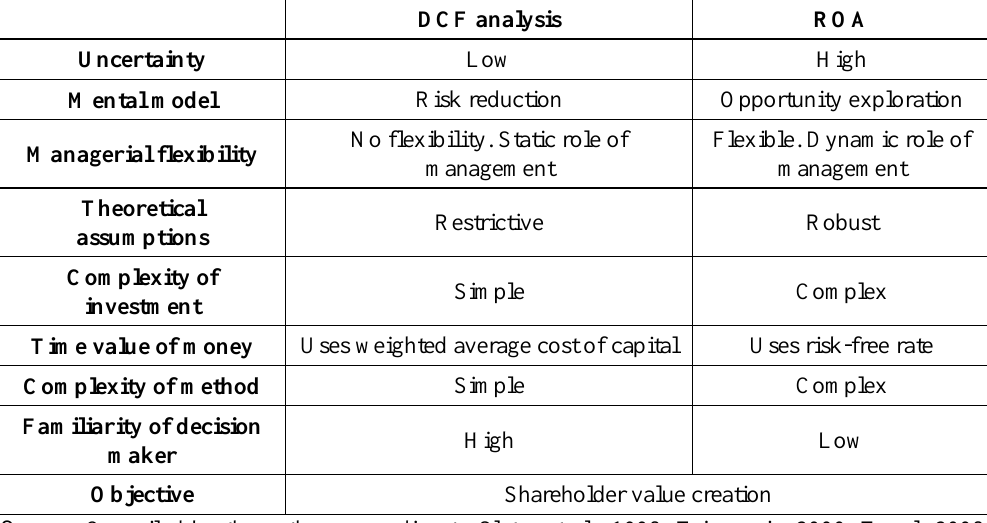
Table 2. Comparison of DCF Analysis and Real Options